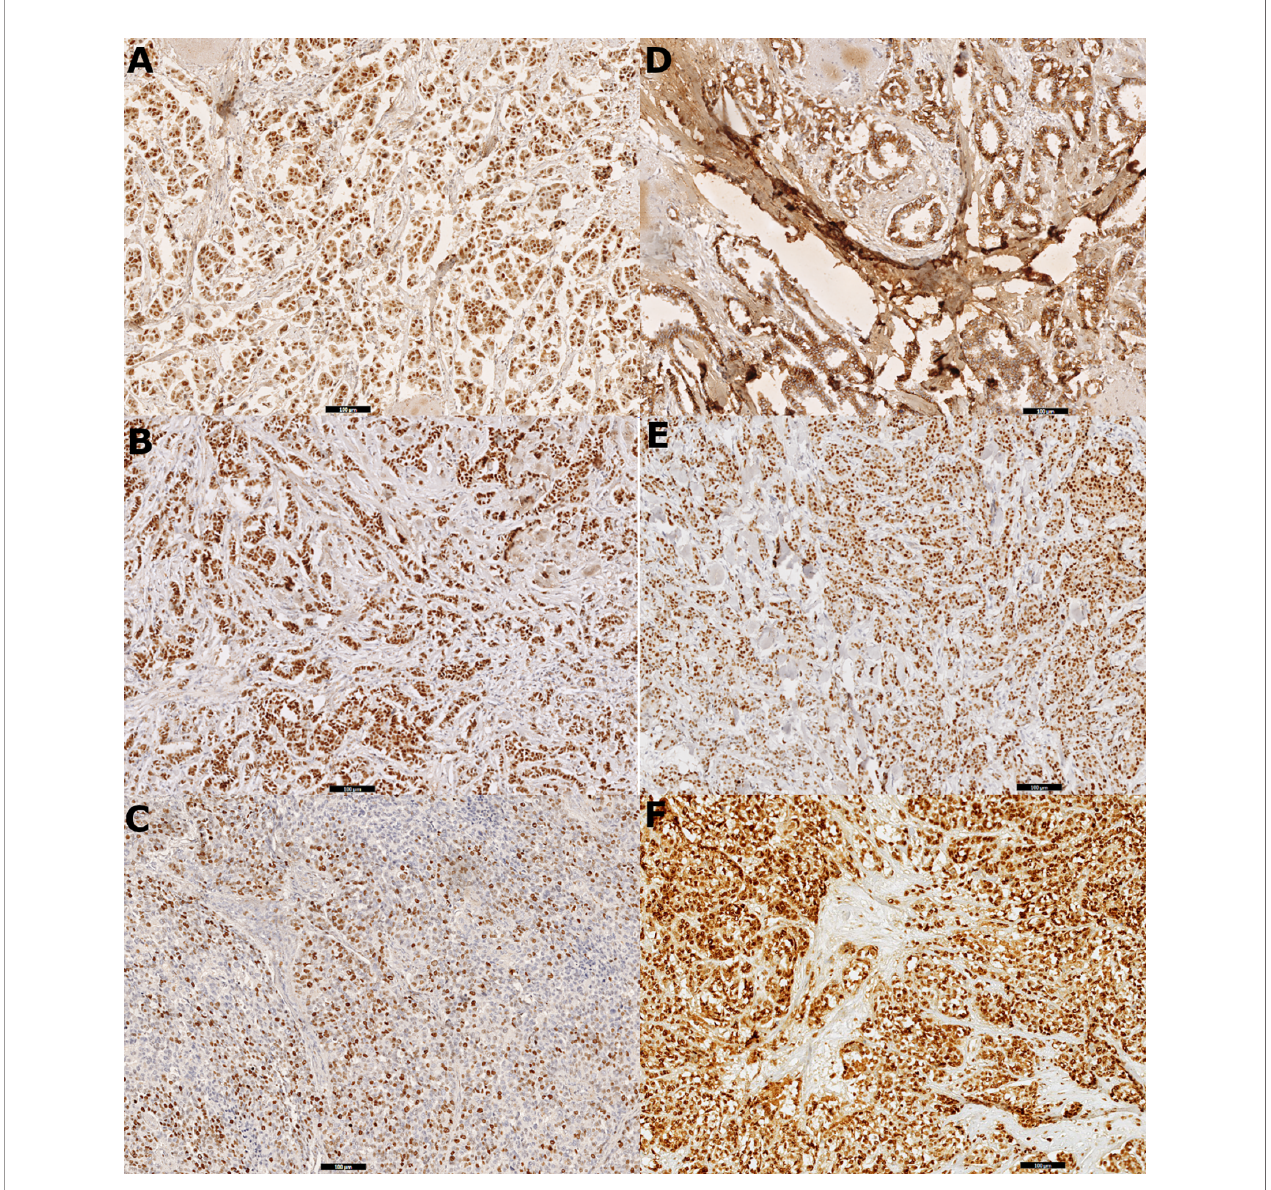
FIGURE 1 | Digital scans presenting (A) strong positive (3+) immunohistochemistry staining for estrogen receptor (ER) in 100% cells in primary tumor tissue, (B) strong positive (3+) immunohistochemistry staining for progesterone receptor (PR) in 100% cells in primary tumor tissue, (C) Ki-67 immunohistochemistry staining: 80% positive tumor cells in node metastasis, (D) positive immunohistochemistry staining for E-cadherin in primary tumor tissue, (E) strong positive (3+) immunohistochemistry staining for cyclin D1 in 90% cells in primary tumor tissue, and (F) strong positive (3+) immunohistochemistry staining for Snail+Slug (mix) in 100% cells in primary tumor